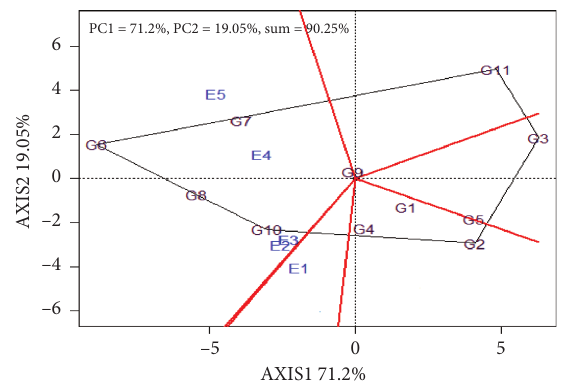
Figure 4: The polygon view of GGE biplot based on genotype scaling showing which genotype won in which locations for tuber yield. The biplots were based on scaling � 0, centering � 2, and SVP � 1. Genotypes: G1 � 95/0194, G2 � 95/18544, G3 �